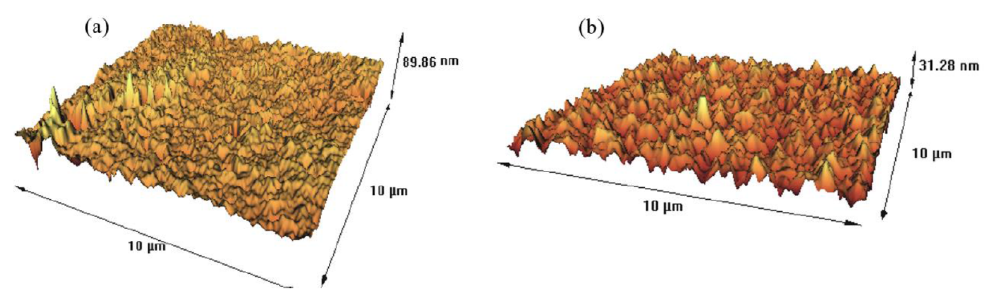
Figure 11. AFM three dimensional topographic images of the surface of ( a ) the blank PVD-HFP film and ( b ) the optimized PIM consisting of 50 wt% PVDF-HFP, 40 wt% Aliquat ® 336 and 10 wt% DBP.